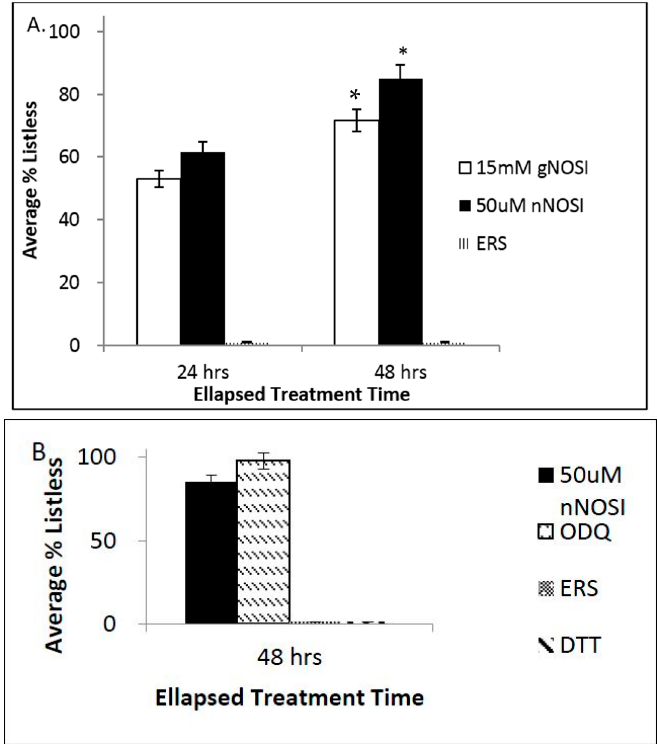
Figure 2. The effects of both general NOS inhibitor (gNOSI) and nNOSI on creating the listless/PD-like symptoms in 6 pdf treated zebrafish and the type of NO pathway engaged in this type of phenotype. ( A ) Both gNOSI and nNOSI create the listless symptoms over a 48 h treatment period; however, the nNOSI results are significantly greater (* p < 0.05) than that of gNOSI treatments at approximately 90% demonstrating the listless/PD-like symptoms compared to 75%, respectively; ( B ) Oxadiazolo[4,3-a]quinoxalin-1-one (ODQ) treatment, a sGC inhibitor in the NO/sGC/cGMP-dependent pathway, initiates the listless phenotype in a manner similar to that of nNOSI, where DTT, an S -nitrosilation NO/sGC/cGMP-independent pathway inhibitor, has no effect and is not significantly different form that of the ERS controls (* p > 0.05). Bars equal ±